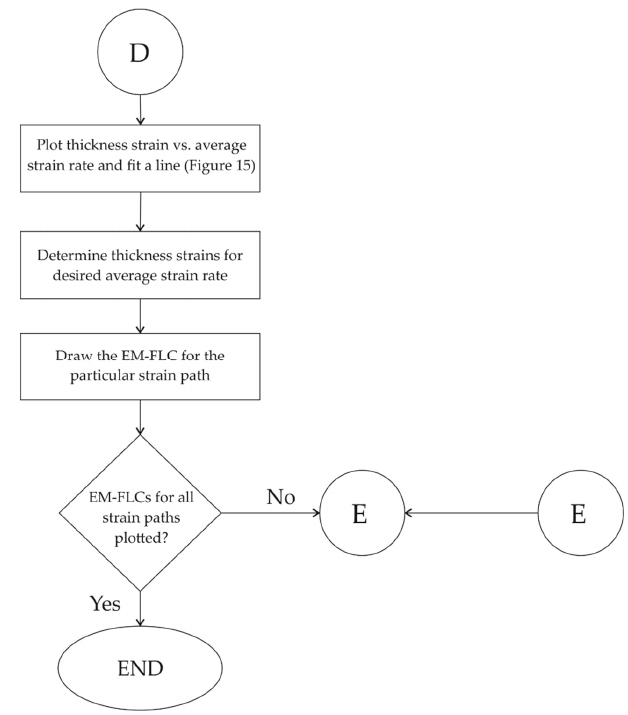
Figure A5. Average strain rate determination at the apex.